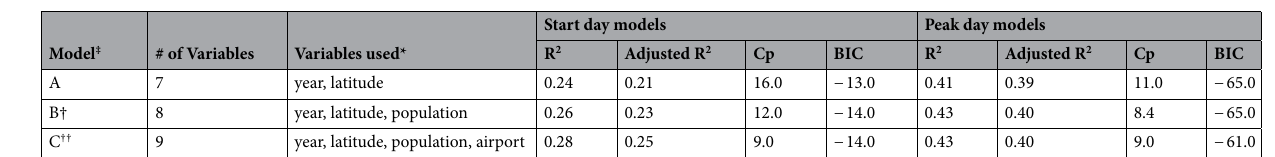
Table 1. Multivariate regression model selection for influenza-like illness start day and peak day, using best subset method. ‡ Best model for all possible models with the given numbers of variables using RSS. *Year was considered as 6 dummy variables and was forced in. Strain was excluded given the high correlation with year. † Selected peak day model. †† Selected start day